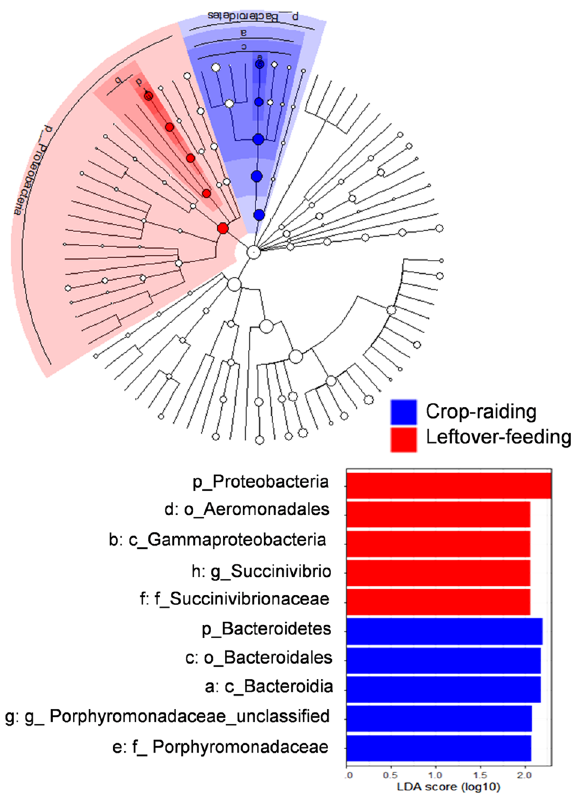
Figure 7. Differentially expressed bacterial taxa between crop-raiding and leftover-feeding groups found in LeFSe analysis (LDA > 2).